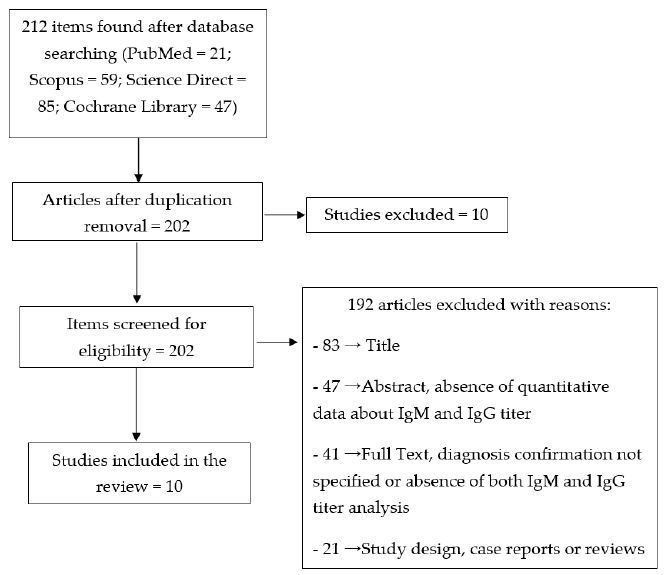
Figure 1. Flow chart of the item assessments. Table 1. Quality evaluation of the included